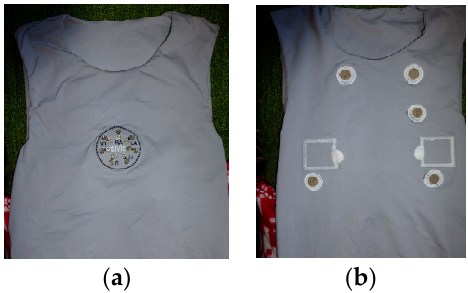
Figure 3. Photos of the T-shirt prototype for cardiorespiratory surveillance; ( a ) outer front-side, and ( b ) inner side.